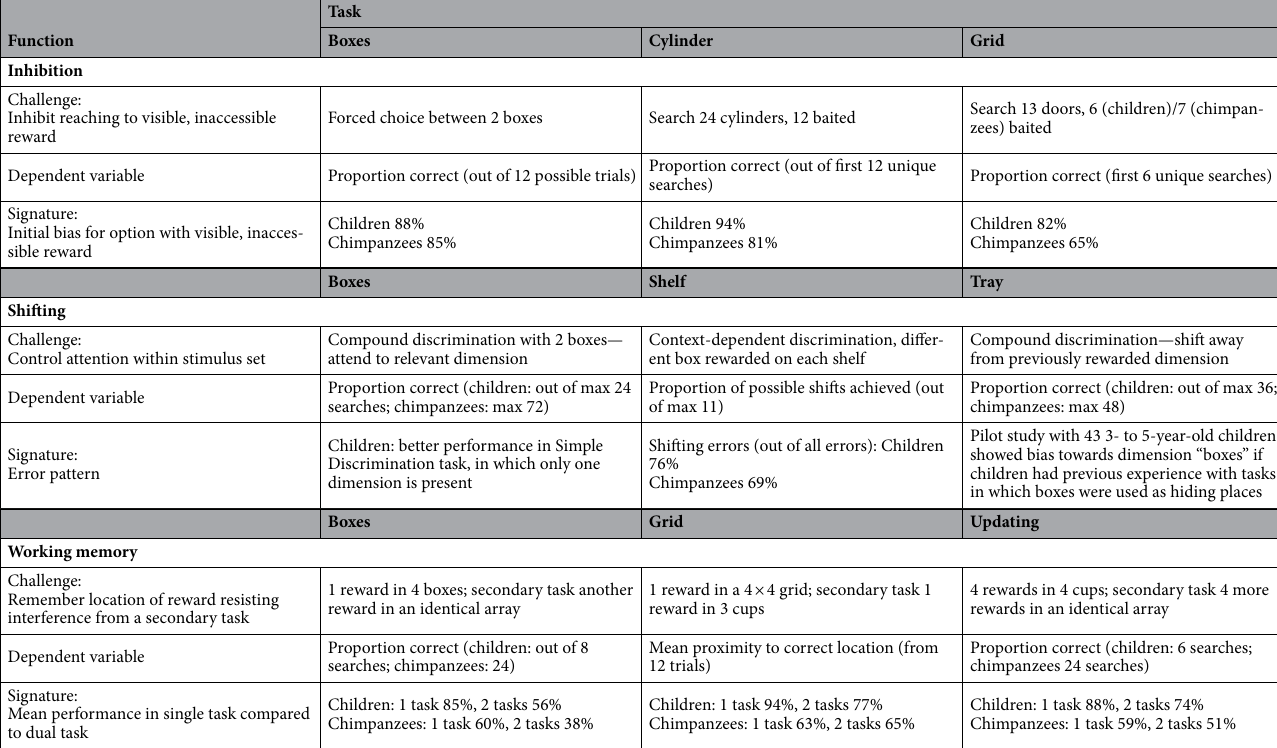
Table 1. Overview of descriptions and signatures for the nine executive functions tasks. Data presented in the “signature” rows stem from the current study (for the sample sizes for each task, see Tables 2 and 3), with the exception of the Shifting Tray task, for which we established content validity in a pilot study with 43 3- to 5-year-old children. For most tasks, we also ran pilot studies and these confirmed the signatures (see Table S1). We did not use “proportion correct” dependent variables for the WM Grid and the Shifting Shelf task because the alternative dependent variables (WM Grid: proximity to correct location, standardized to values between 0 and 1 with higher values indicating higher proximity to the correct location; Shifting Shelf: proportion of achieved shifts) yielded more variation between individuals and evidence for above-chance performance in children and chimpanzees (see Supplementary